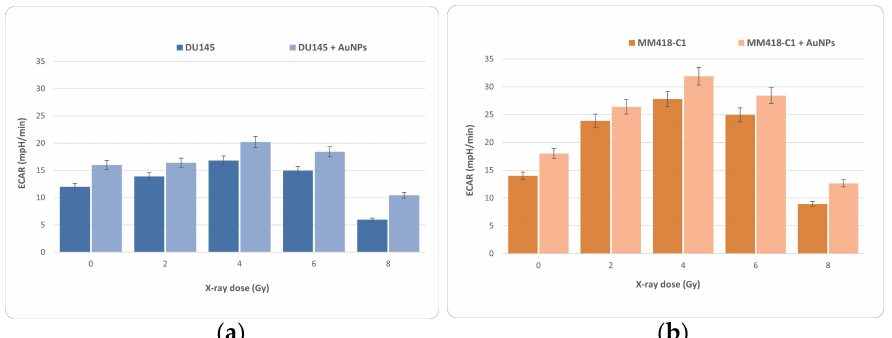
Figure 8. Data from the glycolysis stress test which represent extracellular acidification rate (ECAR) traced from a mitochondrial stress test when DU145 ( a ) and MM418-C1 ( b ) cell lines were irradiated with and without AuNPs. Data represent mean values from 20 wells ± standard deviation of three replicate samples.